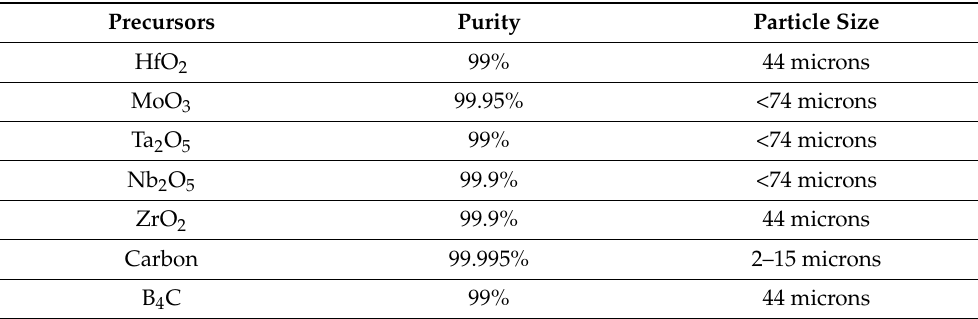
Table 1. The purity and particle size of the starting precursor materials used in the high-pressure high-temperature synthesis of high-entropy boride.